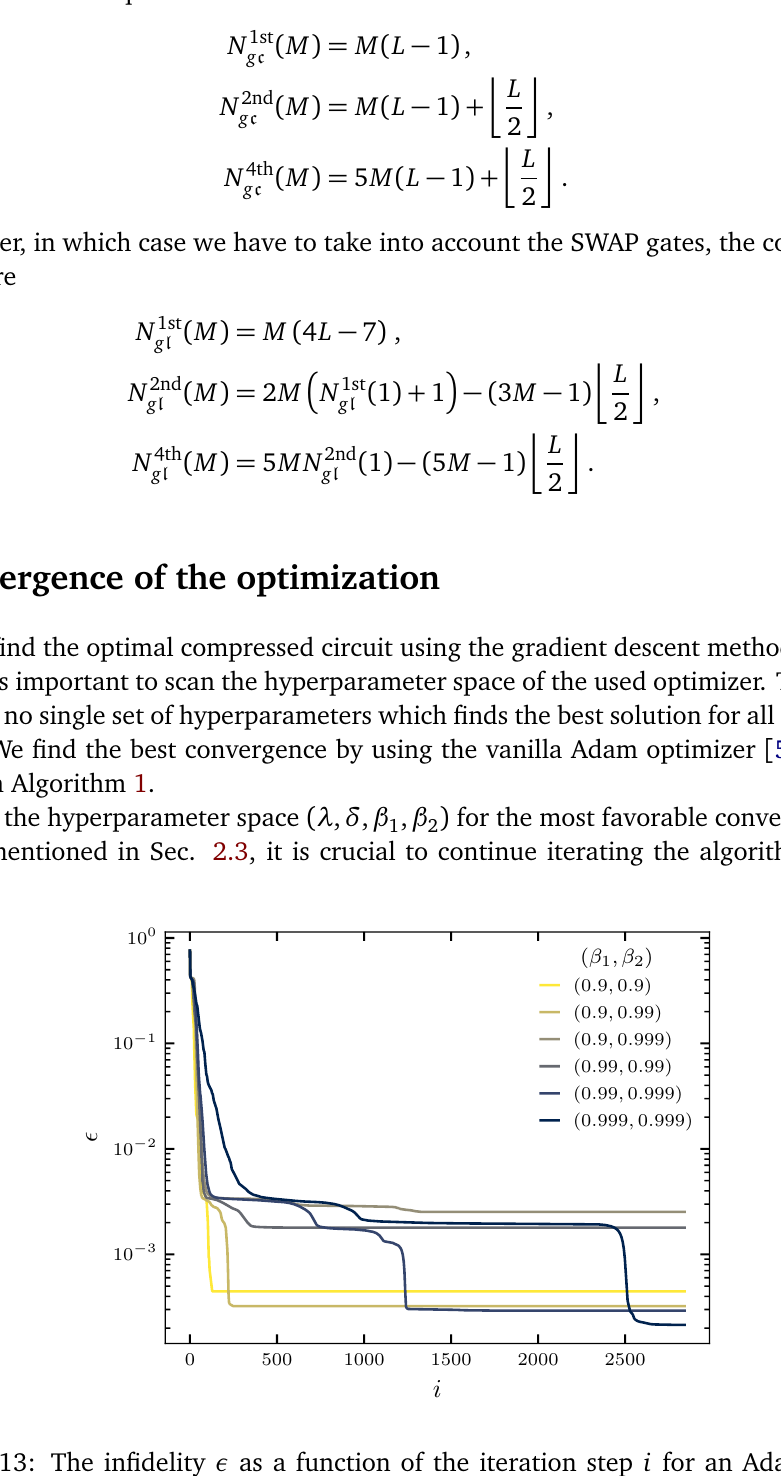
Figure 13: The infidelity ε as a function of the iteration step i for an Adam opti- mizer with learning-rate τ = 0.01, regularization δ = 10 − 4 , and various decay rates ( β ) with β ∈ { 0.9,0.99,0.999 } . The optimization is performed for a size , β , β 1 2 1 2 L = 8 ladder at time t = 1 with circuit depth M = 8. The lowest infidelity is reached with ( 0.999,0.999 ) , but crucially this requires the optimizer to spend time in local minima without getting stopped by a convergence criterion when the infidelity has